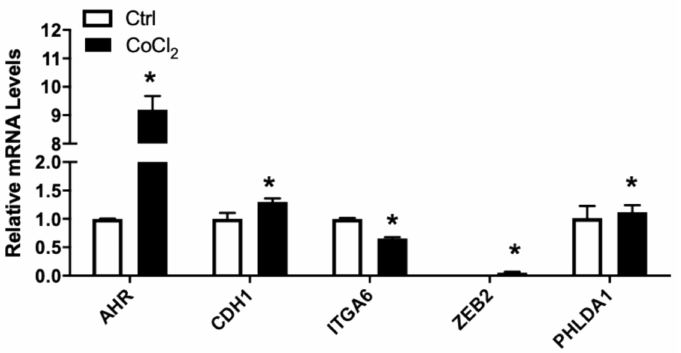
Figure 5. Relative mRNA levels of selected genes in LNCaP cells treated without/with CoCl 2 . LNCaP cells were subjected to CoCl 2 -induced hypoxia, RNA isolated, and the gene expression analyzed, as described in Materials and Methods. Results were normalized to the untreated control and expressed as relative mRNA levels (mean ± SD, n = 3); p -values ≤ 0.05 were considered as significant and * indicates significantly different from control.